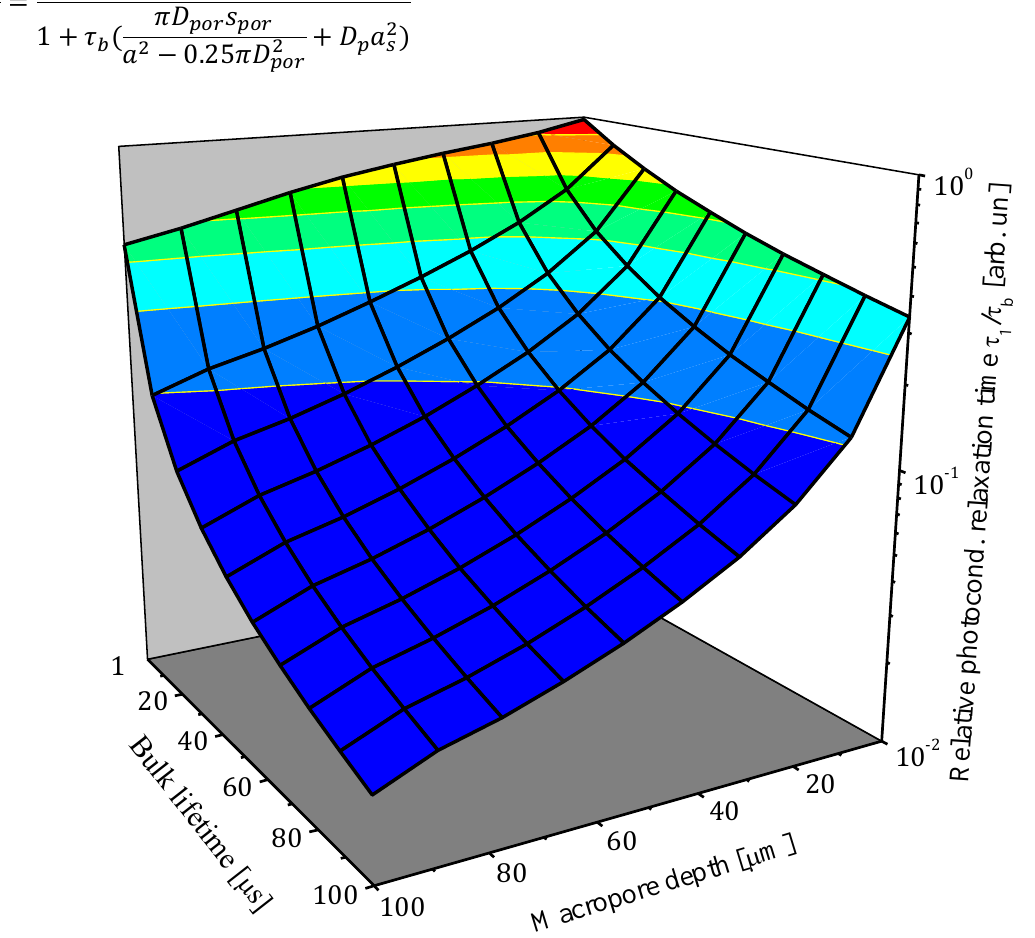
Figure 5. The dependence of the relative relaxation time of photoconductivity on the depth of the macropores and the bulk lifetime at thickness of macroporous silicon is 100